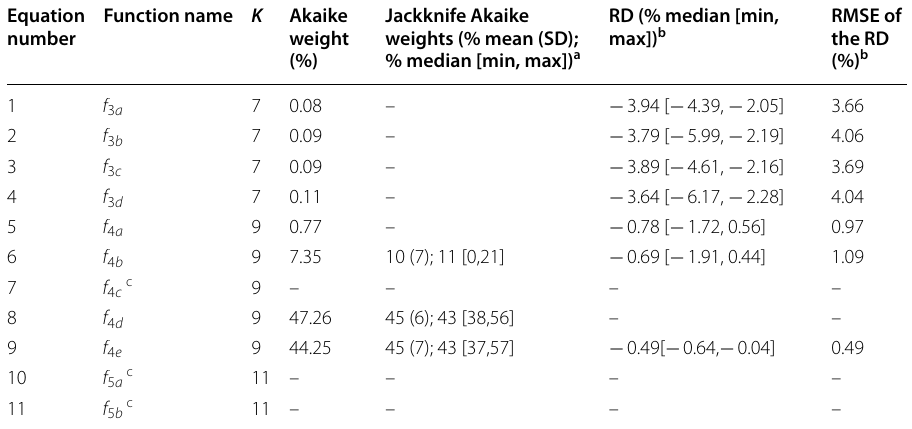
The total number of biokinetic data N used in this analysis is 40; the number of parameters of the NLME model for the corresponding SOE function is given in column K a The Jackknife analysis was based on functions with Akaike weights > 1%, i.e. f 4 b , f 4 d , and f 4 e b Function f 4 d was used as the reference for the calculation of the RDs and RMSEs of the all‑time‑point TIAs c Functions f 4 c , f 5 a , and f 5 b did not pass the goodness‑of‑fit test because CV > 50%; therefore, Akaike weights, RDs, and RMSEs were not calculated for these functions